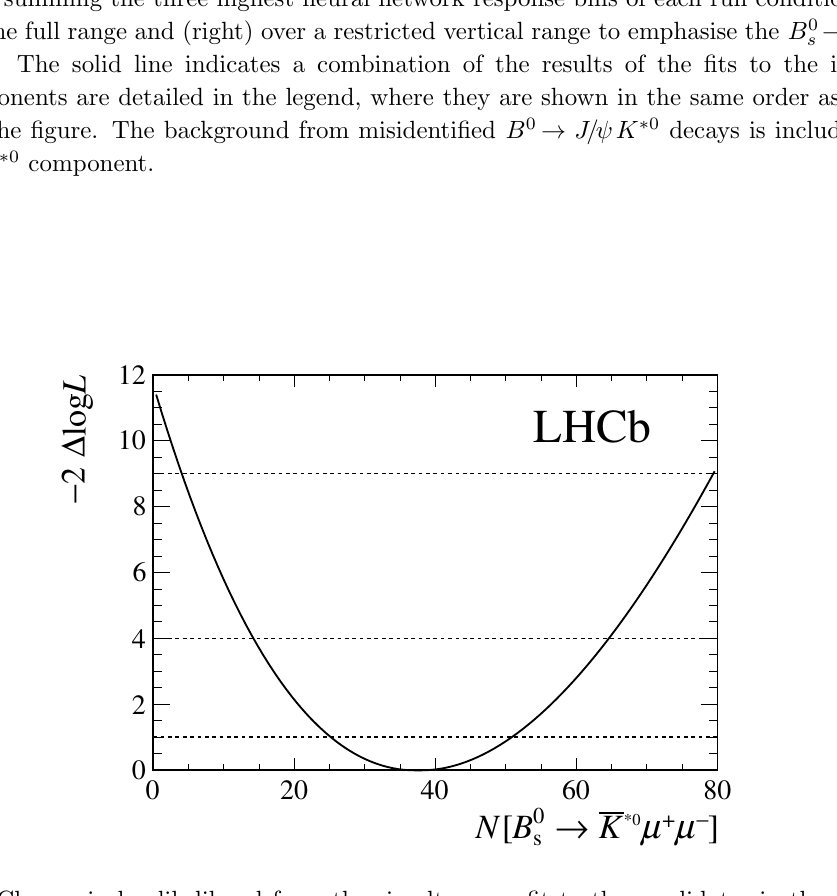
! K (cid:3) 0 (cid:22) + (cid:22) (cid:0) s